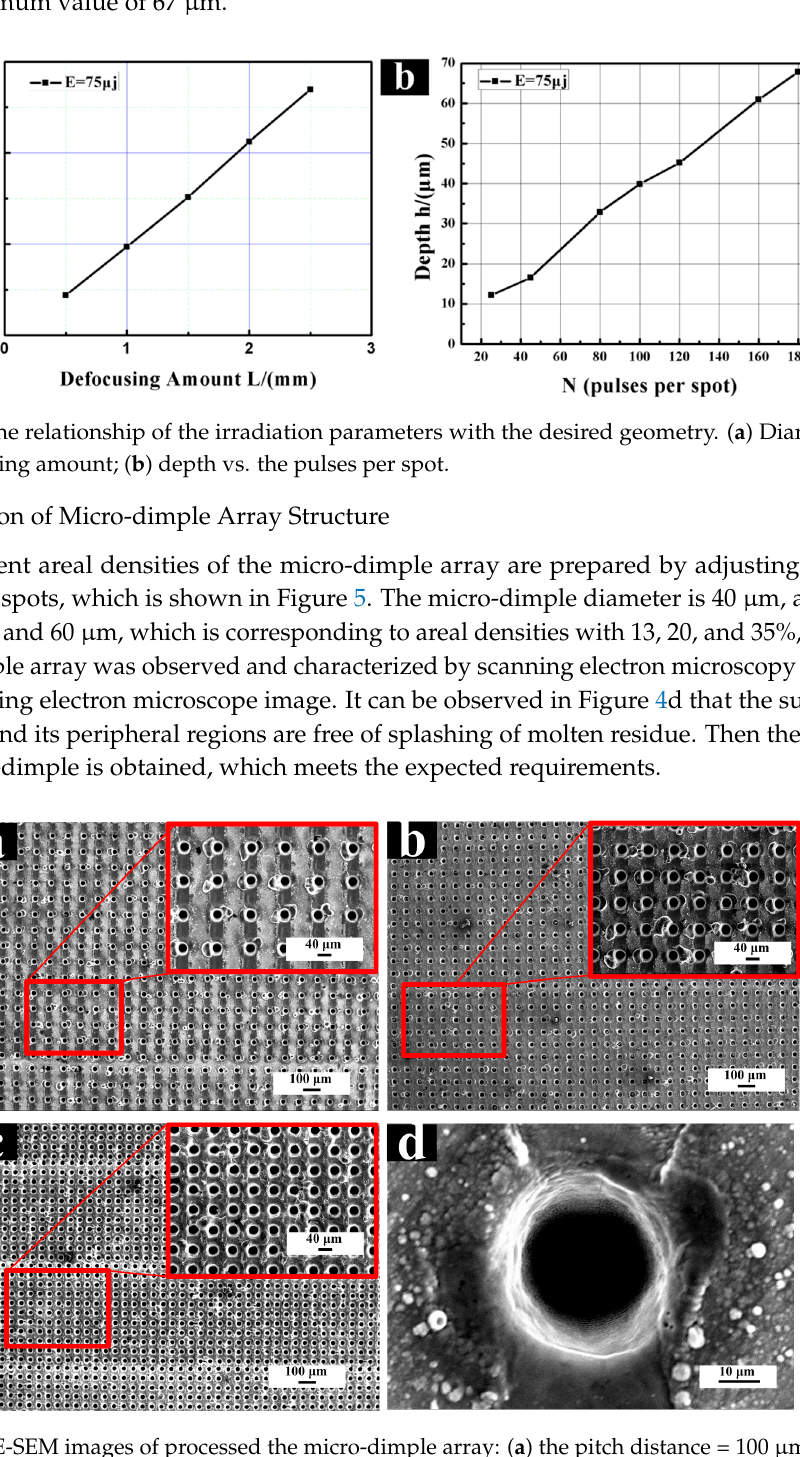
Figure 5. FE-SEM images of processed the micro-dimple array: ( a ) the pitch distance = 100 μ m; ( b ) the pitch distance = 80 μ m; ( c ) the pitch distance = 60 μ m; ( d ) the morphology of a single micro-dimple.